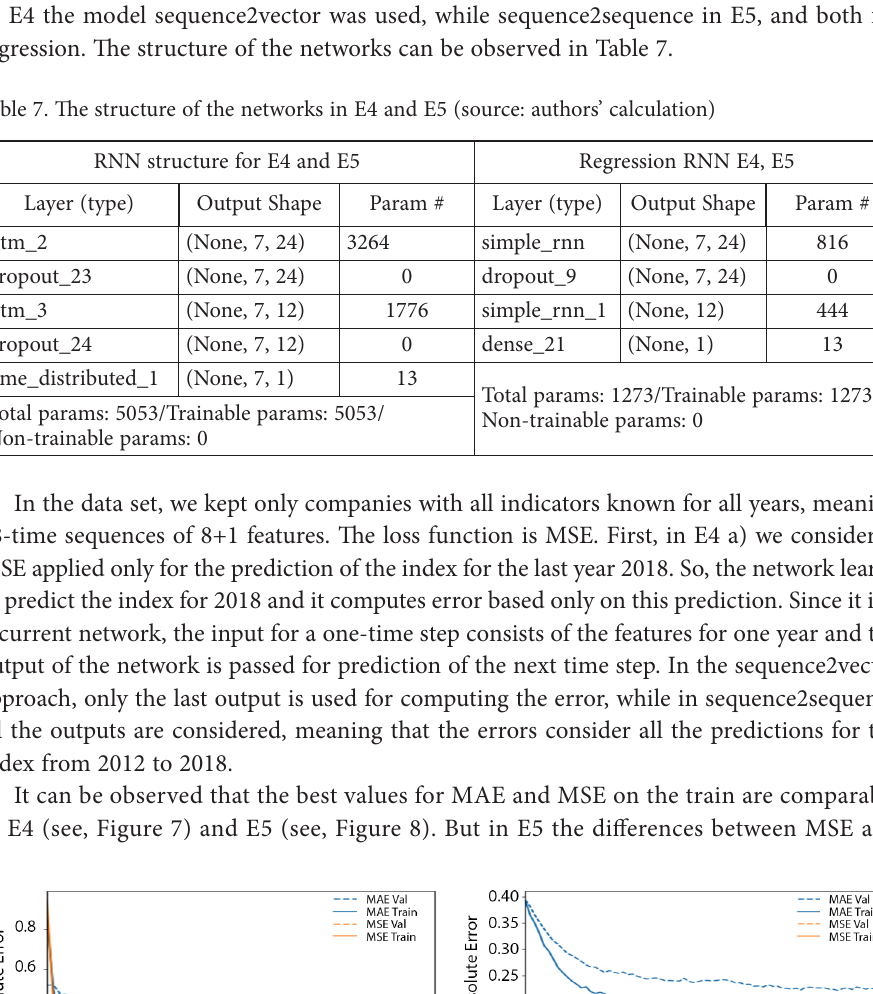
Figure 7. E4. Simple RNN for sequences of length 7 (average MSE 0.03/0.21, MAE 0.13/0.33)